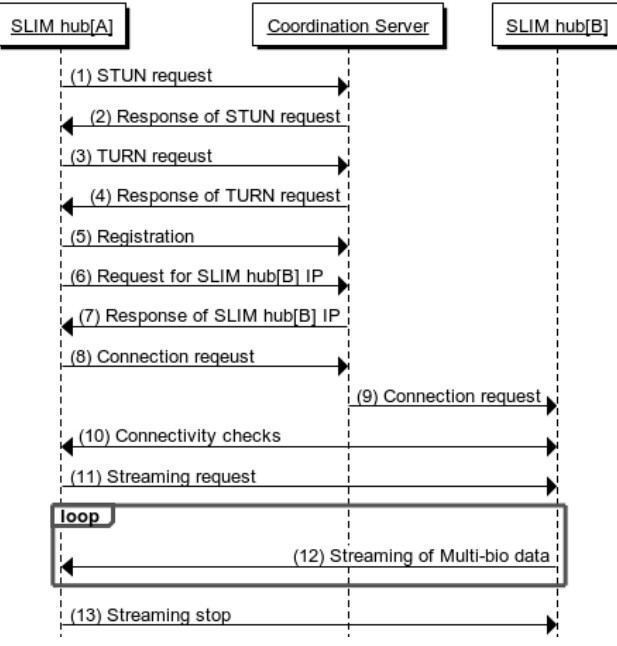
Figure 13. Sequence diagram of SLIM hubs in other private network.